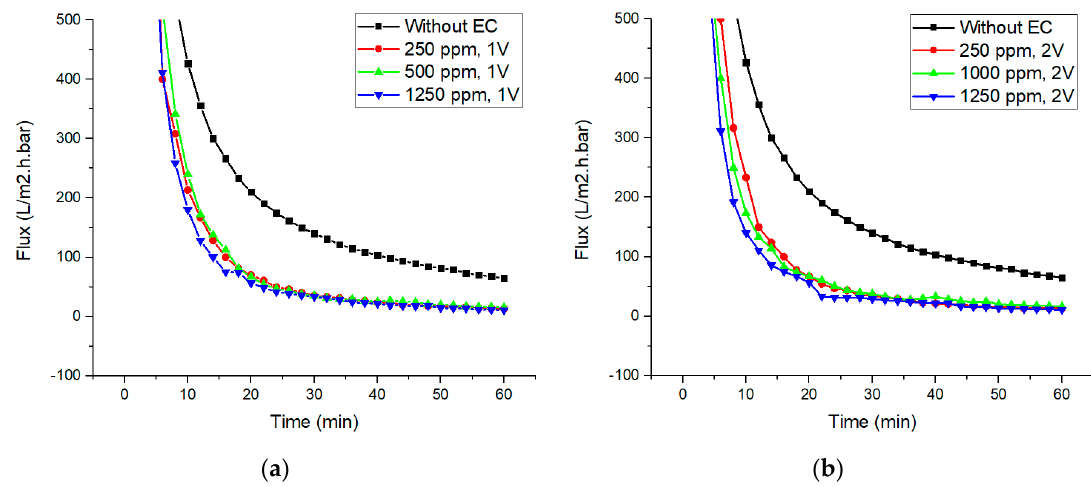
Figure 6. Permeability flux for electrocoagulation-integrated membrane using ( a ) 250 ppm, 500 ppm and 1250 ppm of NaCl at 1V and ( b ) 250 ppm, 1000 ppm and 1250 ppm NaCl at 2 V, constant 10 ppm Celestine blue dye and constant pH 7.